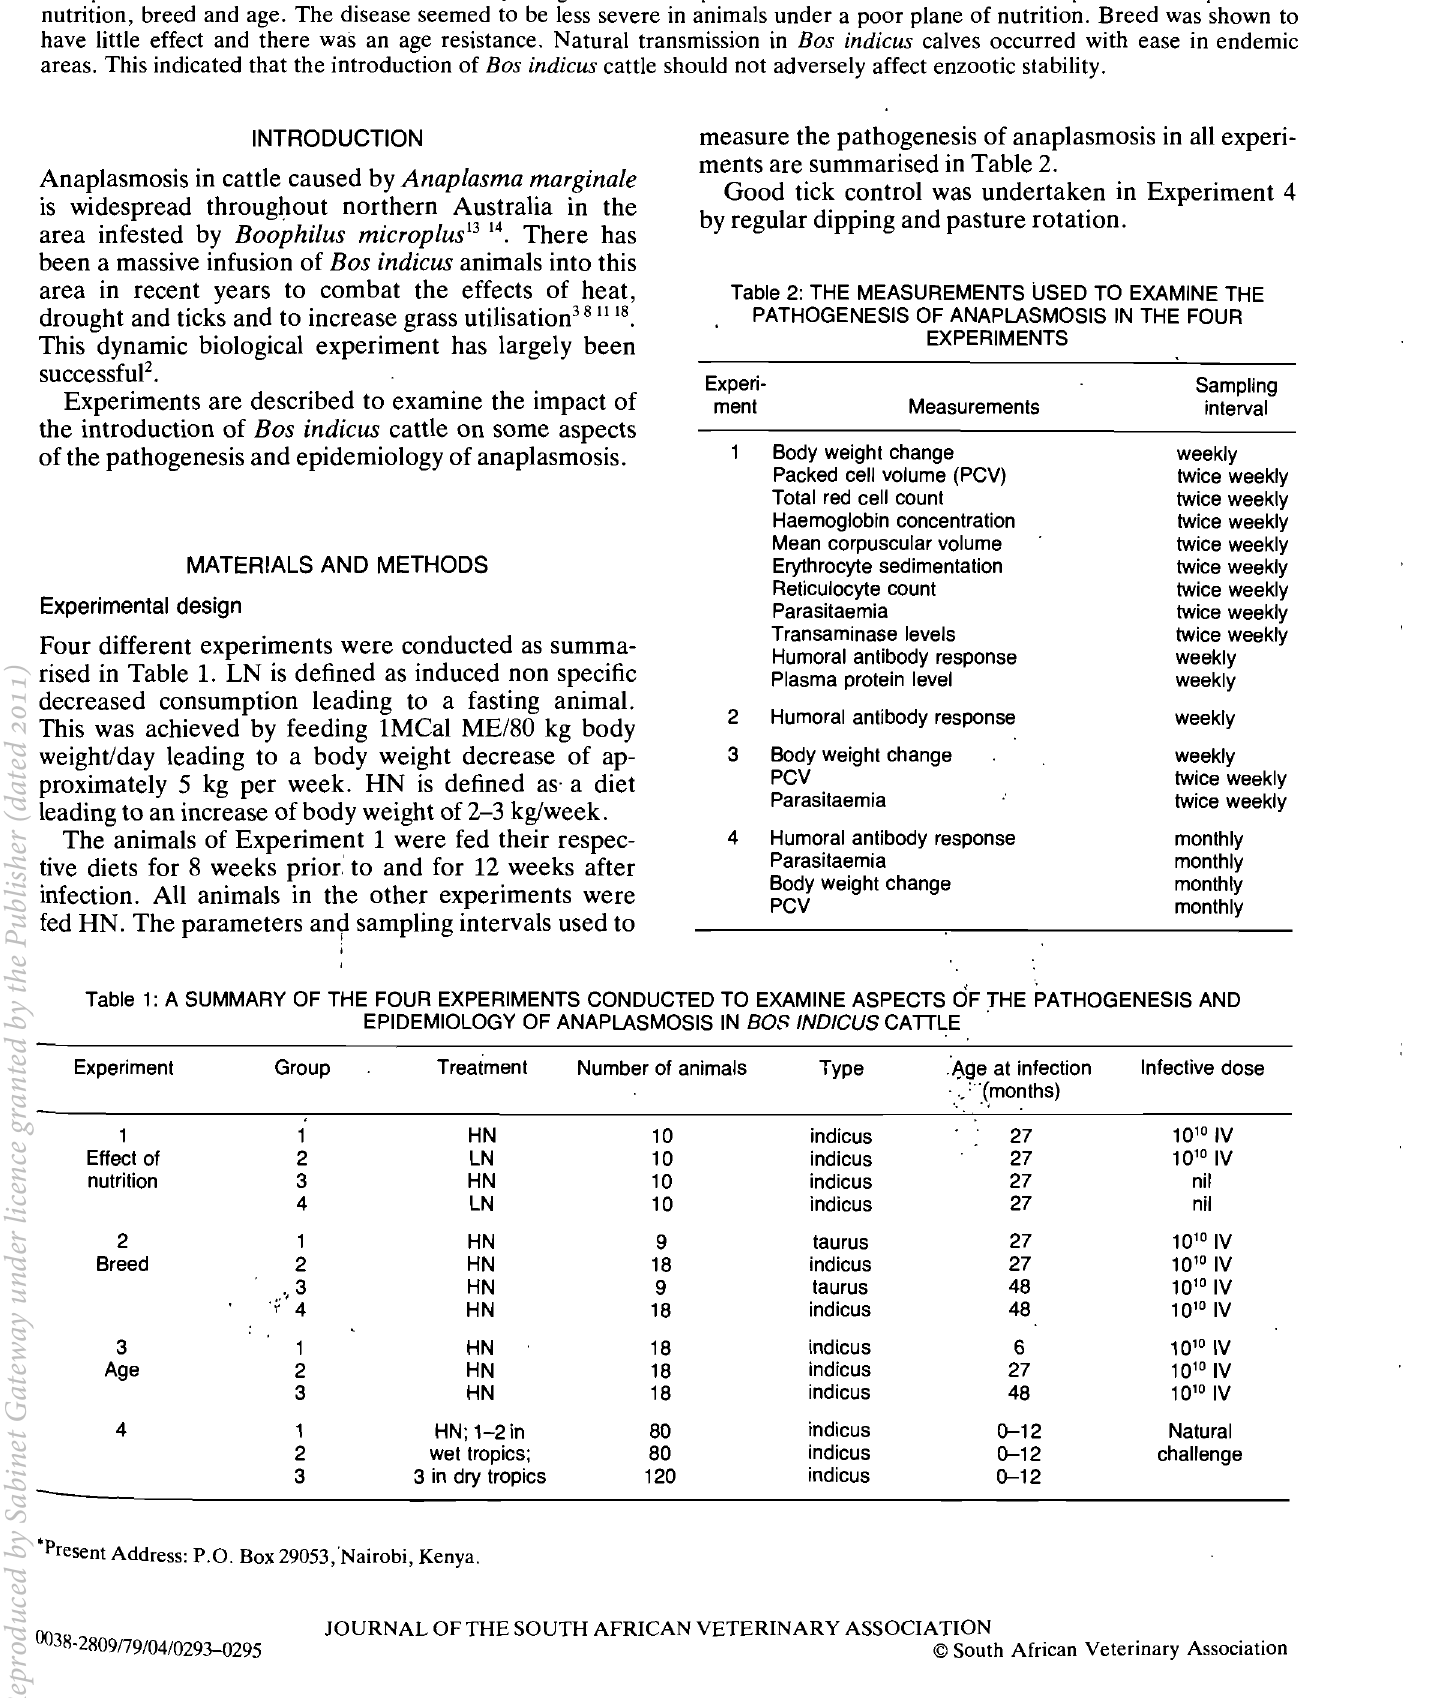
Table 2: THE MEASUREMENTS lJSED TO EXAMINE THE PATHOGENESIS OF ANAPLASMOSIS IN THE FOUR